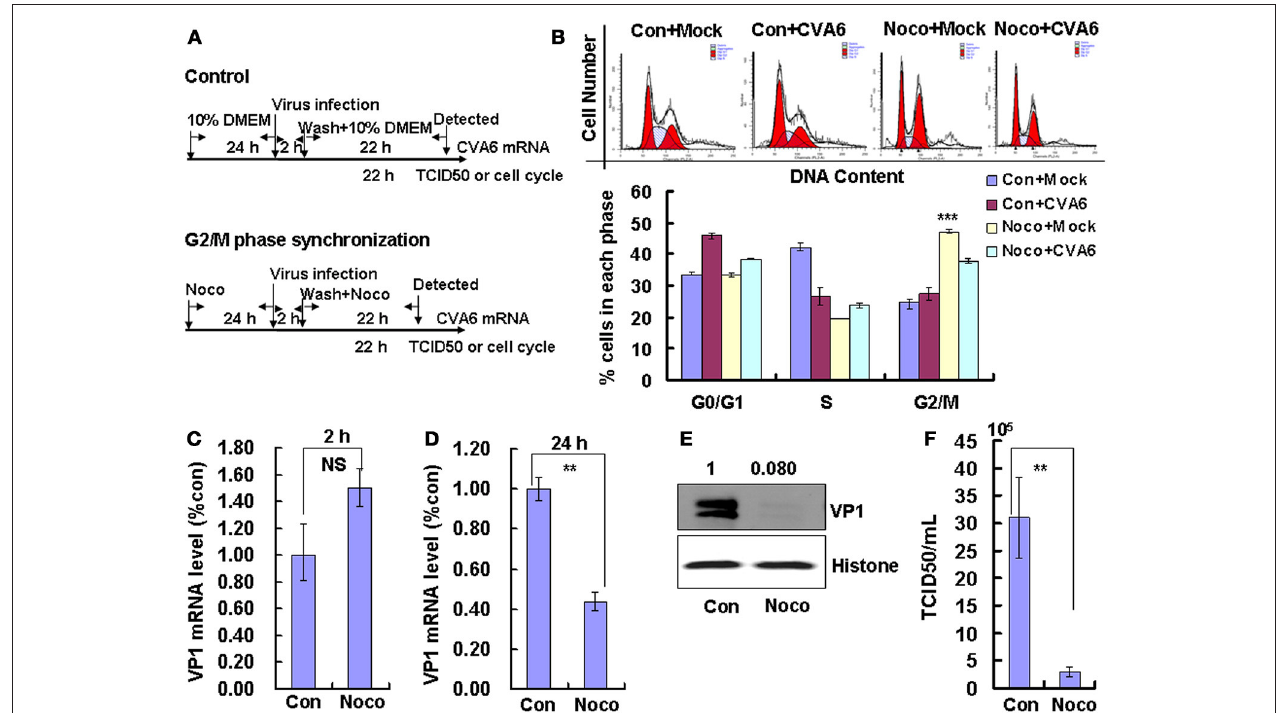
FIGURE 4 | G2/M-phase synchronization by nocodazole inhibits viral production. (A) For G2/M synchronization, RD cells were cultured in control medium (Con) or 25ng/mL nocodazole (Noco) for 24h. Then cells were infected with mock (Mock) or CVA6 (CVA6) at an MOI of 1 for 2h, and then fresh control medium or